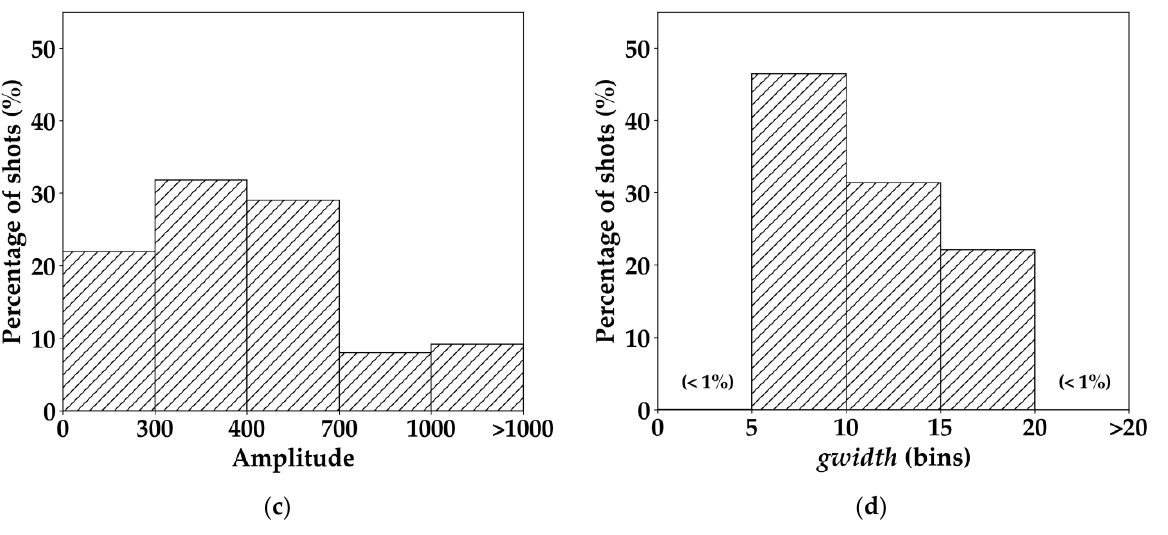
Figure 3. Distribution of GEDI shots according to SNR ( a ), VA ( b ), Amplitude A ( c ), and gwidth ( d ). One (1) bin corresponds to 15 cm.